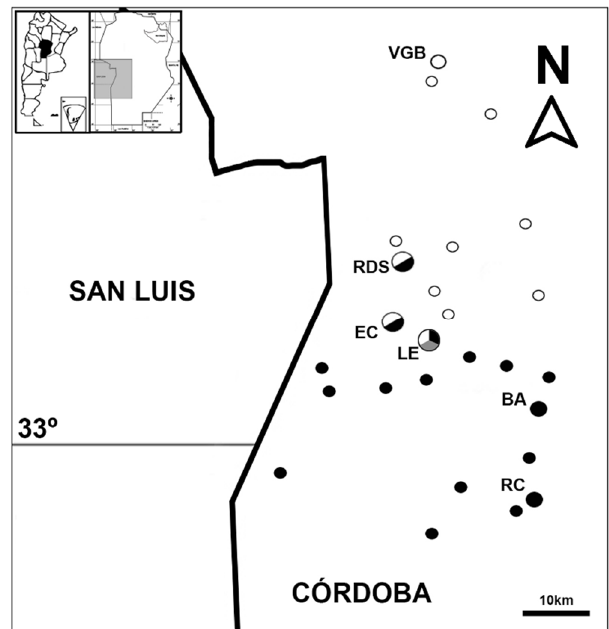
Figure 1. Map of the study localities. White dots indicate localities with exclusively O. cordobae , black dots localities with exclusively O. americanus , dots with 2–3 three color codes mixed assemblages (gray color indicates the presence of triploids). VGB = Villa General Belgrano, RDS = Rio de los Sauces, EC = El Cano, LE = La Escondida, BA = Coronel Baigorria, RC = Rio Cuarto. The broad line marks the western border between the provinces of Cordoba and St. Luis. Inserts give the location of the study site within Argentina. Table 1. Geographical features of the six Odontophrynus populations sampled in the province of Cordoba, Argentina. Distance gives the line-of-sight distance between a locality and the La Escondida locality. The local Odontophrynus taxa are listed.